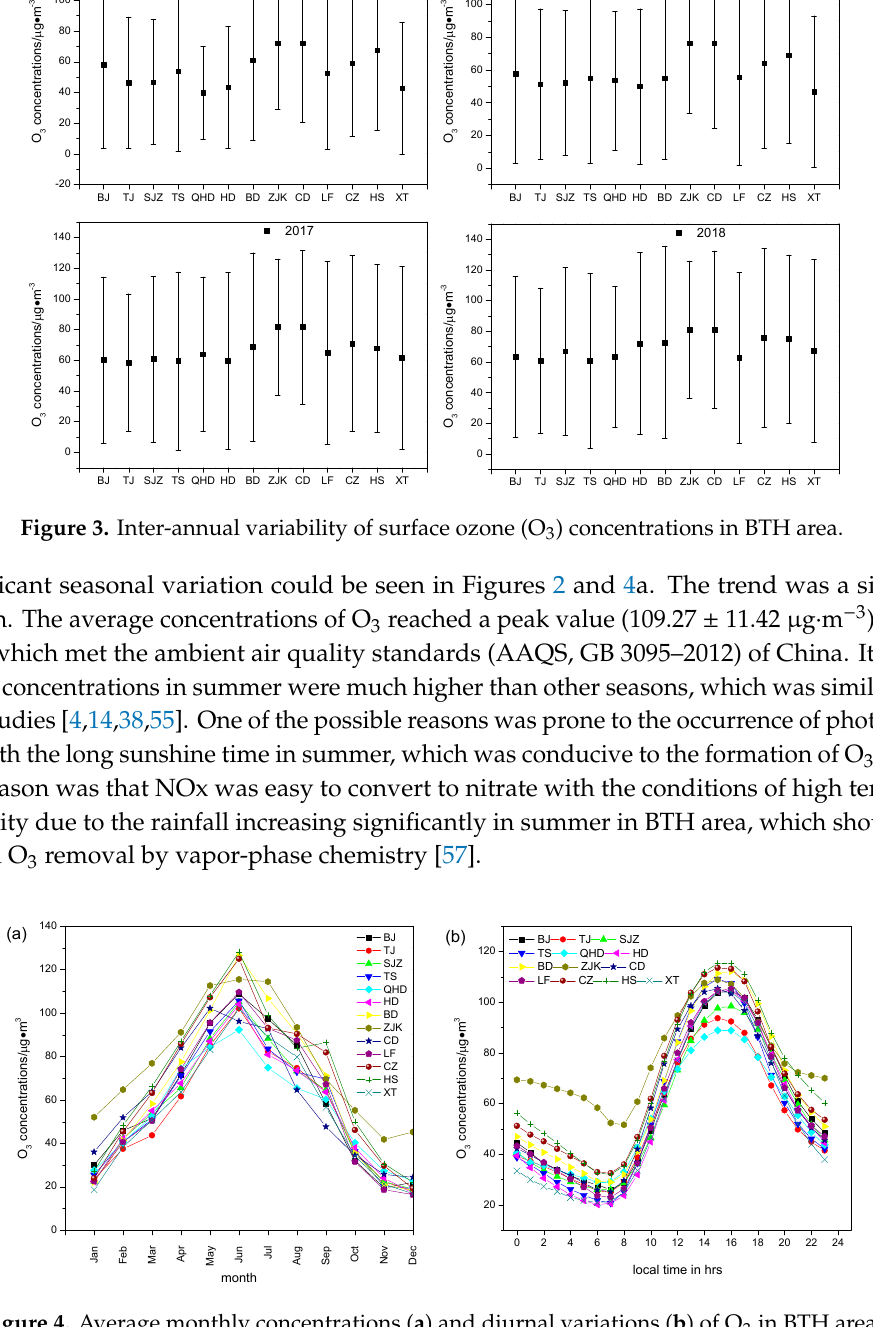
Figure 4. Average monthly concentrations ( a ) and diurnal variations ( b ) of O 3 in BTH area.